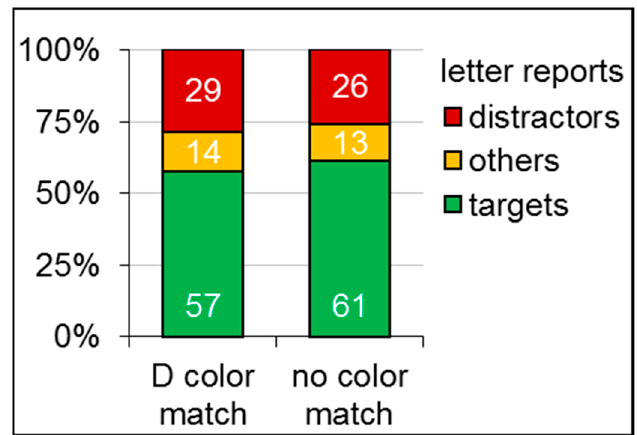
Table 2. Means and standard deviations (in brackets) in percent of reported target and distractor letters for the two color-match conditions of Experiment 2.